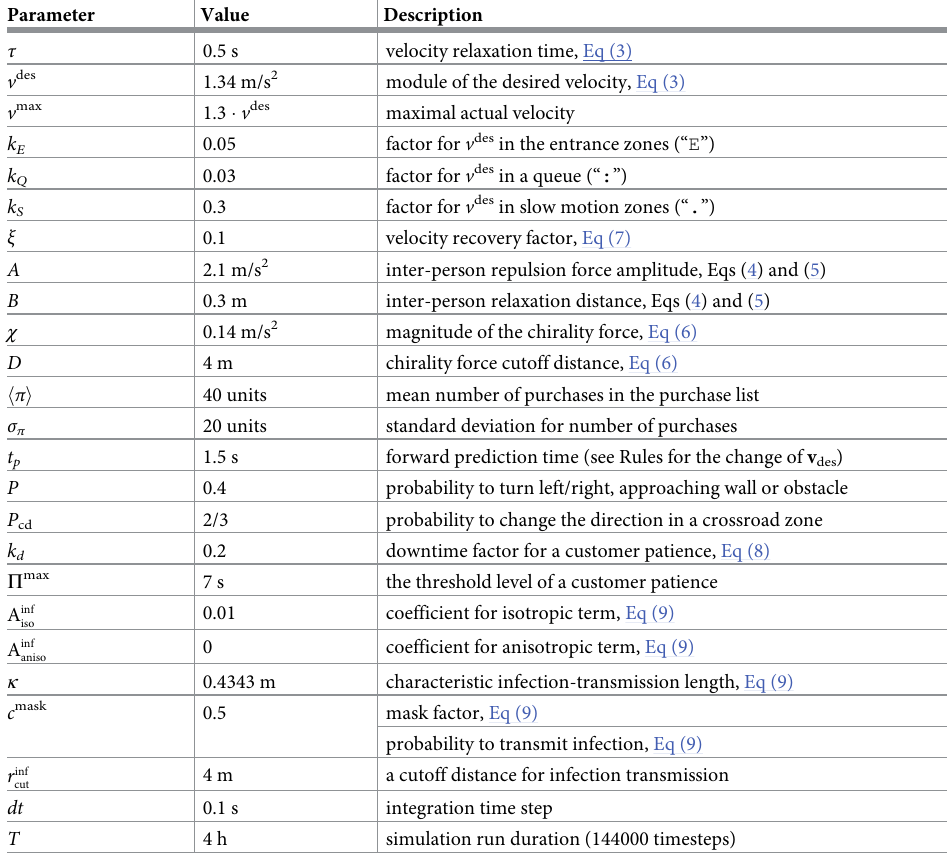
Table 1. Parameters of the composite